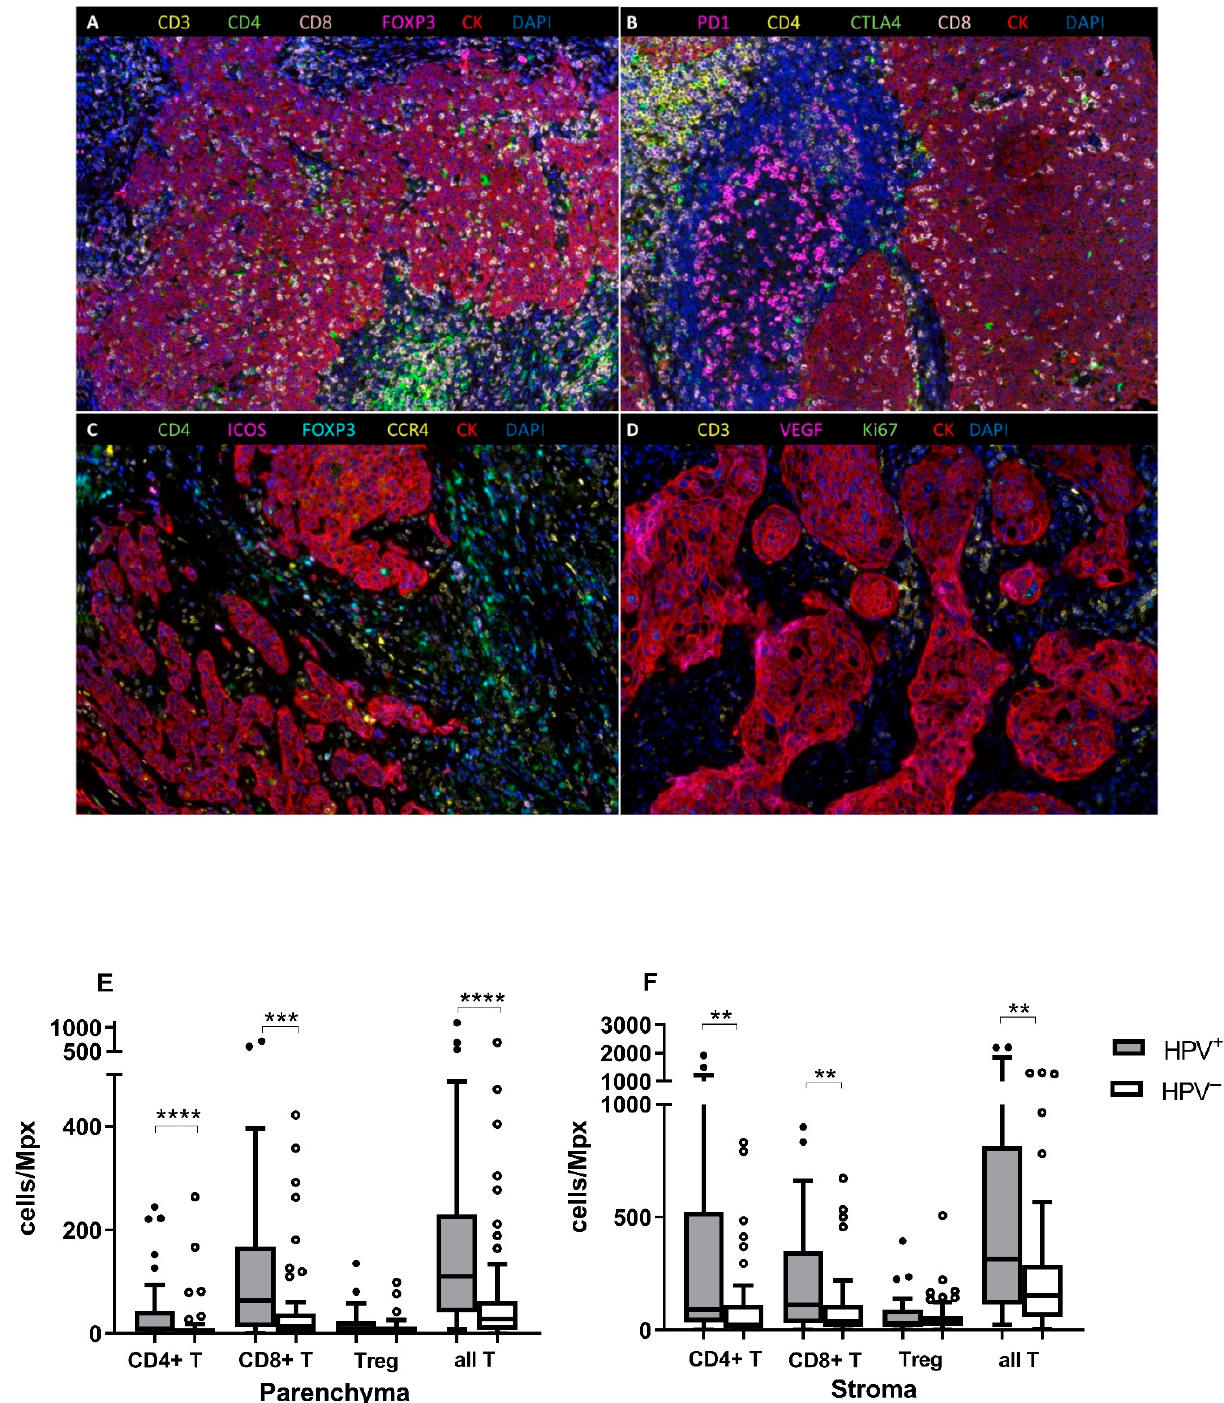
Figure 1. Representative multispectral fIHC staining of FFPE tissue samples with four antibody panels, 20X magnification. ( A ) CD3 (yellow), CD4 (green), CD8 (pink), FOXP3 (magenta), CK (red), and DAPI (blue) staining. ( B ) PD-1 (magenta), CD4 (yellow), CTLA4 (green), CD8 (pink), CK (red), and DAPI (blue) staining. ( C ) CD4 (green), ICOS (magenta), FOXP3 (cyan), CCR4 (yellow), CK (red), and DAPI (blue) staining. ( D ) CD3 (yellow), VEGF (magenta), Ki67 (green), CK (red), and DAPI (blue) staining. T lymphocytes infiltration in the parenchyma and the stroma compartments according to tumor etiology. ( E ) The numbers of CD3 + CD4 + , CD3 + CD8 + , all CD3 + T lymphocytes, and Treg cells per Mpx were compared between the HPV + and HPV – groups in the parenchyma and ( F ) the stroma compartments. Significantly higher infiltration of CD3 + CD4 + , CD3 + CD8 + , and all CD3 + T